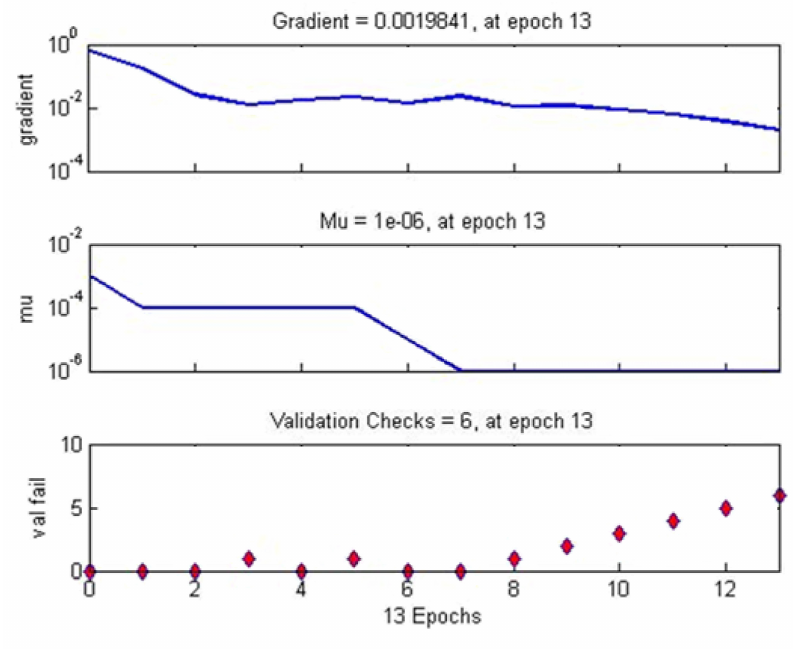
Figure 8. State in the FA-ANN with optimum 8-8-4-1 structure.